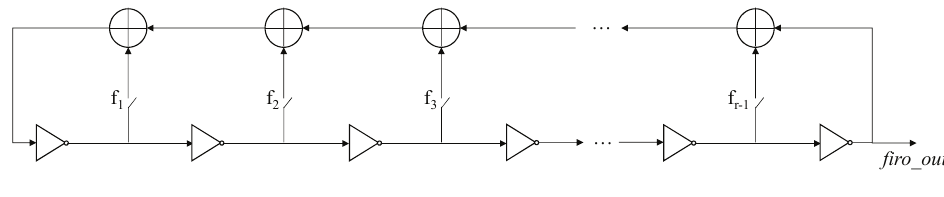
Figure 1: The structure of FIRO.